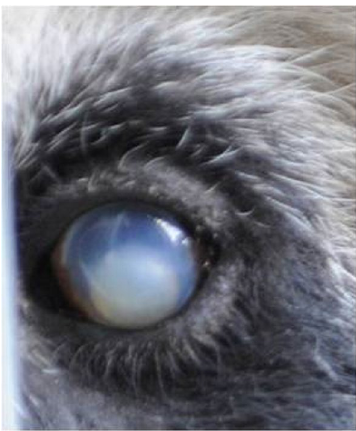
Figure 1. The left eye of Xinxing, a female giant panda with hyper-mature cortical